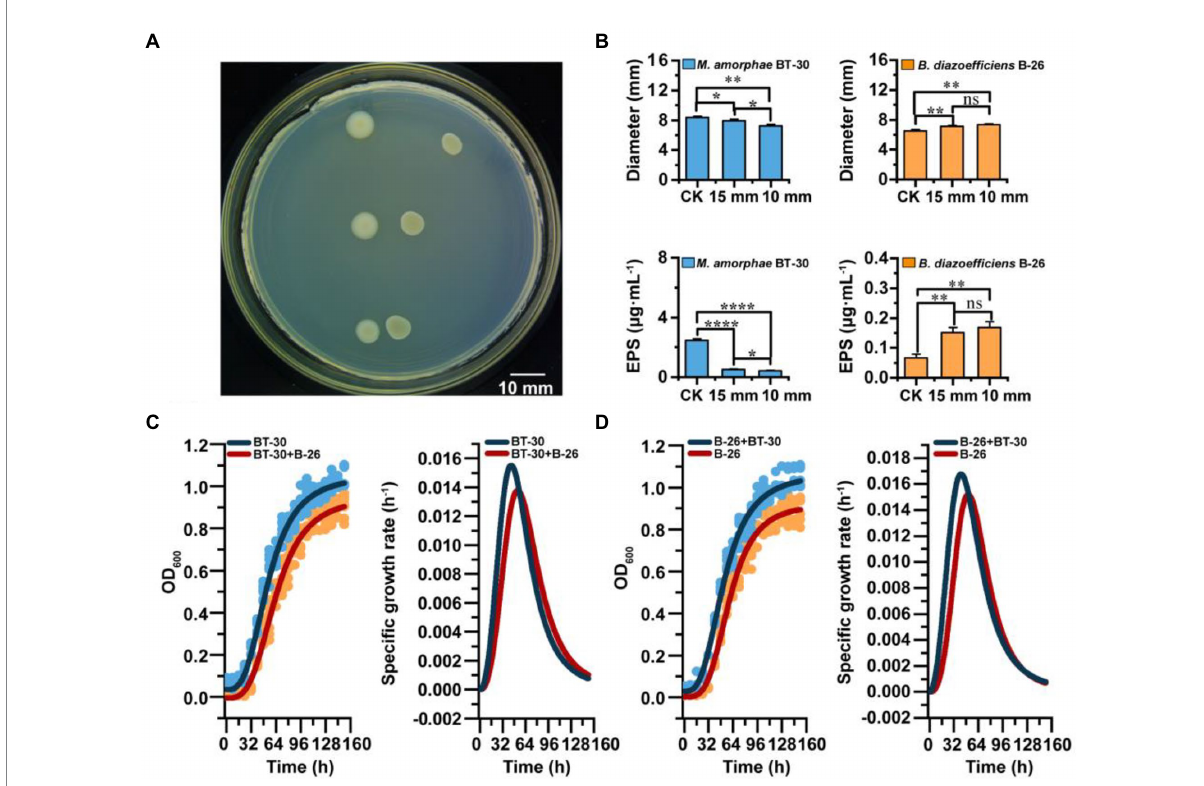
FIGURE 5 Interaction between M. amorphae BT-30 and B. diazoefficiens B-26. (A) Co-cultivation of M. amorphae BT-30 (left) and B. diazoefficiens B-26 (right) at different distances (15 mm and 10 mm) on the YMA plate. The control group was at the top, followed by 15 mm and 10 mm distances. (B) Colony diameter of M. amorphae BT-30 and B. diazoefficiens B-26 at 15 mm and 10 mm away from each other on the YMA plate. The production of EPS of M. amorphae BT-30 and B. diazoefficiens B-26 when they are cocultured on the YMA plate. Asterisks (*, **, *** and ns) indicate significant difference from the control (Welch t -test, p < 0.05, p < 0.01, p < 0.001 and not significant). (C) The growth curves and specific growth rate curves of M. amorphae BT-30 under co-culture and pure culture conditions. (D) The growth curves and specific growth rate curves